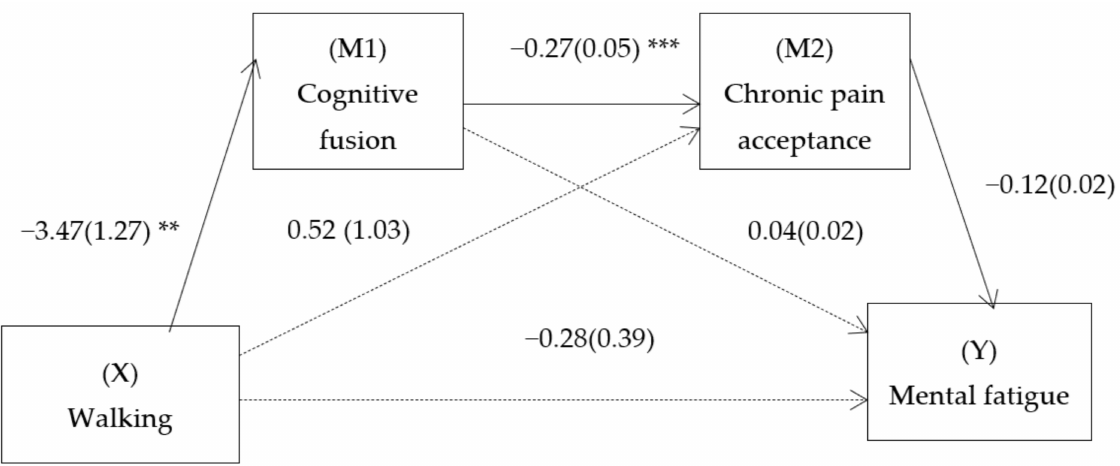
Figure 1. Path diagram illustrating the direct effects and causal paths linking walking (for at least 30 min twice a week, over a minimum of six consecutive weeks) with mental fatigue. Notes: Serial multiple mediation analysis with walking as the independent variable, mental fatigue as the dependent variable, and cognitive fusion and acceptance as the first and second mediators. Values are unstandardized regression coefficients (SE in parentheses) and associated p values (** p < 0.01, *** p < 0.001). Bracketed association=direct effect (controlling for indirect effects). Solid lines indicate significant pathways, and dashed lines indicate nonsignificant pathways.